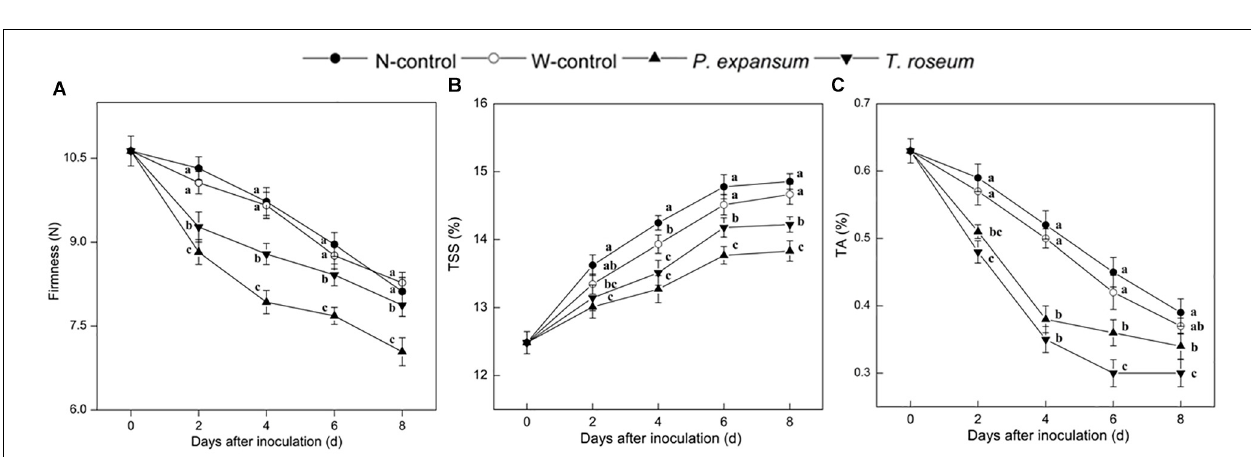
FIGURE 4 | Effects of P. expansum and T. roseum inoculation on firmness (A) , TSS (B) , and TA content (C) of apple fruit during storage. All data are expressed as means ± standard deviation of triplicate samples. Different letters indicate significant differences ( P < 0.05).